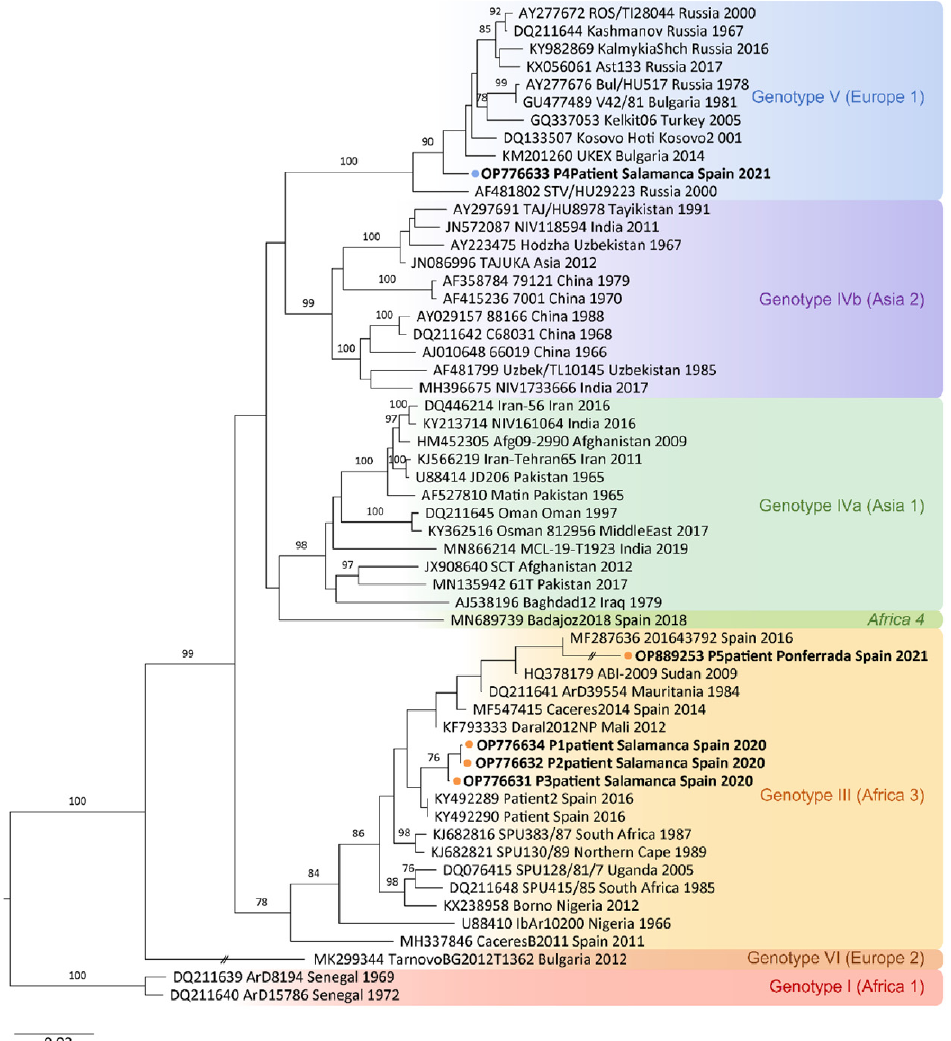
Figure 5. Phylogenetic tree showing the positions of the 51 S-segment sequences used for the CCHFV-RT-LAMP design and the newly identified CCHFV RNA sequences from patients’ samples included in this study. Phylogenetic tree constructed using the neighbour-joining method based on partial (200 nt) sequences of the virus small segment. Numbers in branches indicate bootstrap values for the groups; values <75 are not shown. An interrupted branch (//) indicates its length has been reduced to half. Dots (orange for P1, P2, P3 and P5; blue for P4) and bold letters indicate patients analysed in this study and named by GenBank accession number, locality sampling site, geographic origin, and sampling year; other sequences are indicated by GenBank accession number, strain, geographic origin, and sampling year. Genotypes are indicated by roman numerals and clade nomenclature indicated in brackets, using nomenclature published by Carrol et al. [9] and Chamberlain et al. [55]: I, West Africa (Africa 1); III, South and West Africa (Africa 3); IV, Middle East/Asia, divided in two groups corresponding to groups Asia1 y Asia 2; V, Europe/Turkey (Europe 1); VI, Greece (Europe 2). Italics indicate new lineage, Africa 4 described by Negredo et al. [19]. Scale bar indicates nucleotide substitution per site.